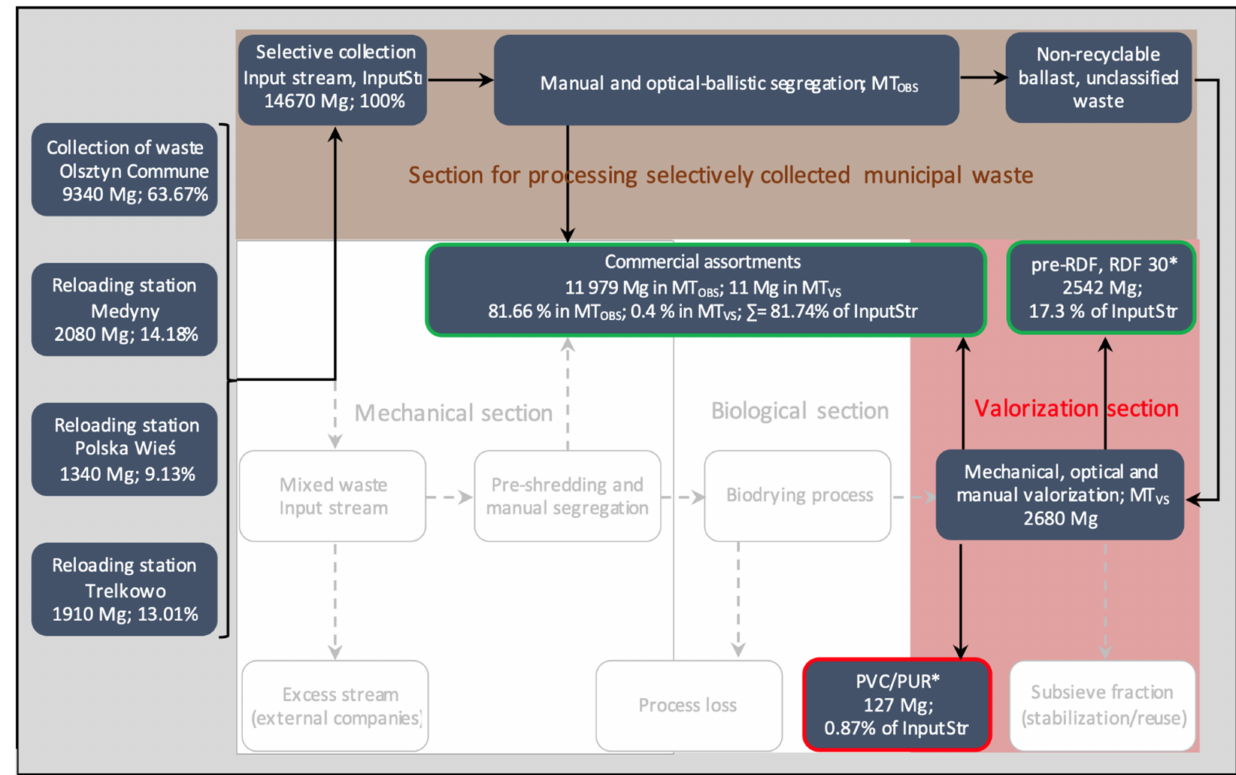
Figure 10. Average mass balance of the Municipal Waste Management Plant in Olsztyn for the years 2016–2020 in the section for processing selectively collected waste (integrated with the valorization section of the MBT line); * RDF—Residual Derived Fuel, RDF 30—Residual Derived Fuel of <30 mm, PVC—Polyvinyl chlorine,